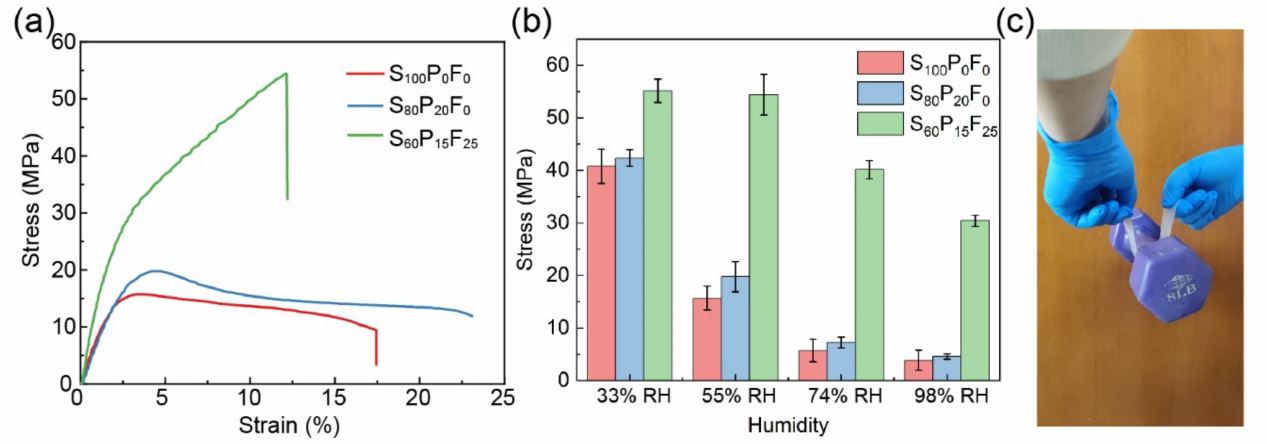
Figure 5. Mechanical properties of different composite films. ( a ) The strain-stress curve of composite films. ( b ) The stress of composite films under different humidity. ( c ) The digital image of the robust SPF films carrying a